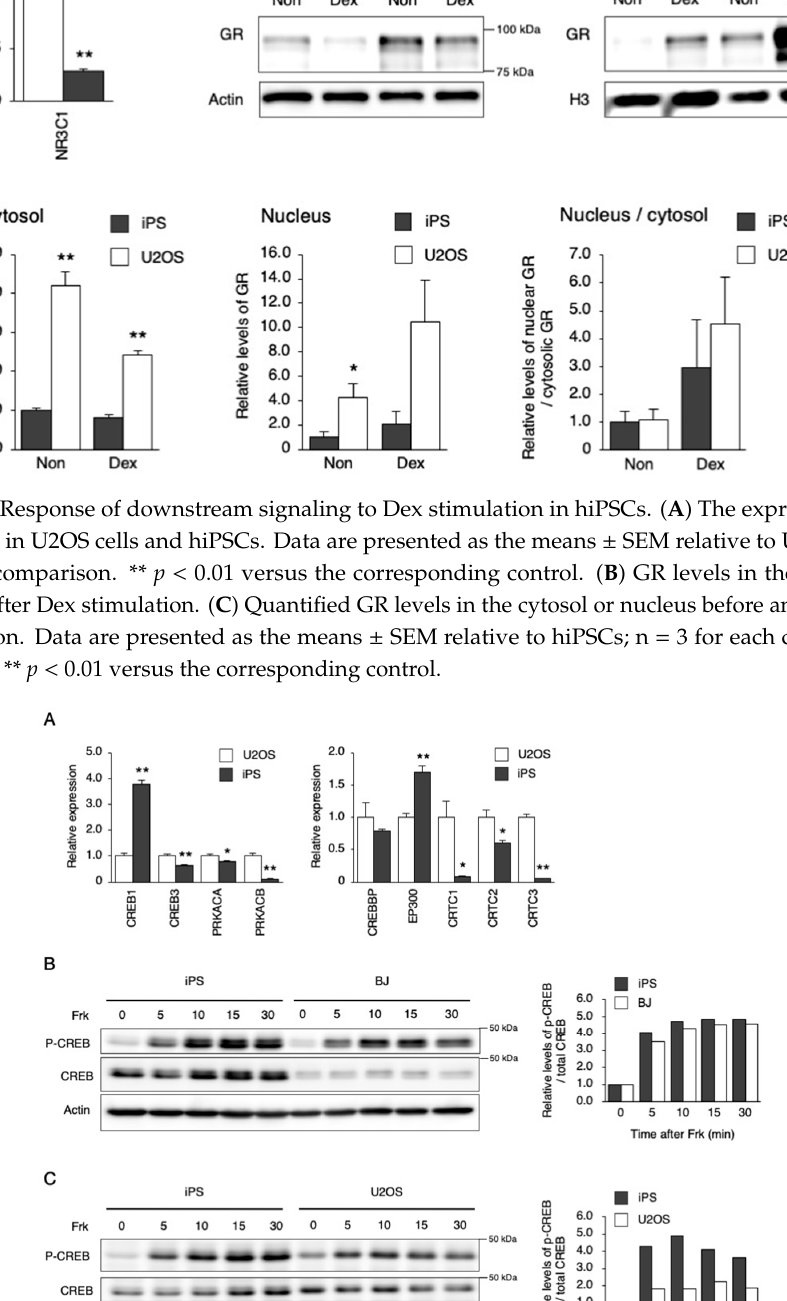
Figure 4. Response of downstream signaling to Frk stimulation in hiPSCs. ( A ) The expression levels of genes involved in cAMP signaling in U2OS cells and hiPSCs. Data are presented as the means ± SEM relative to U2OS; n = 4 for each comparison. * p < 0.05, ** p < 0.01 versus the corresponding control. ( B ) and ( C ) Phosphorylation of CREB by Frk stimulation in hiPSCs, BJ, and U2OS cells. Right graph shows quantified levels of p-CREB / total CREB from left blots, respectively. Data are presented as the means ± SEM relative to each 0 h.